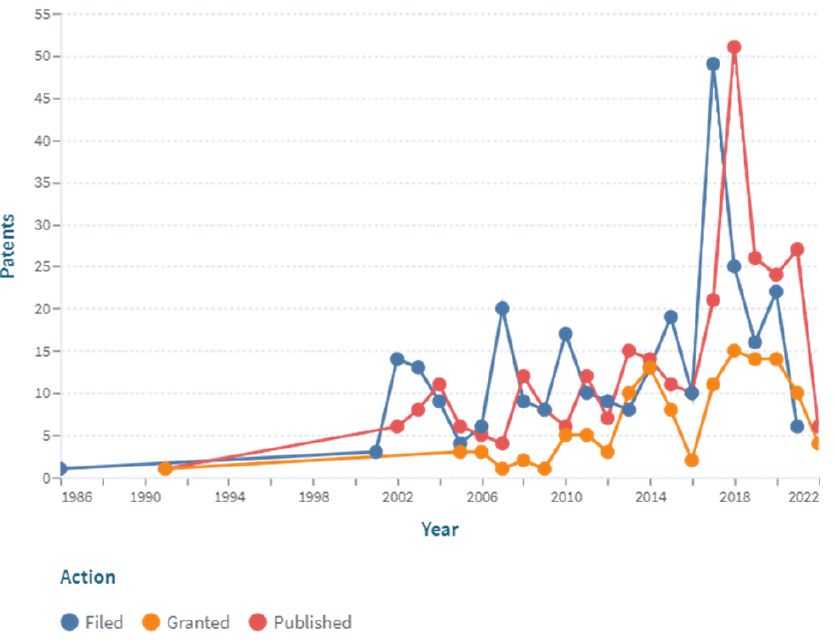
Figure 1. Dynamics of patent activity by applicants in the field of digital pills with ingestible sensor (https://www.lens.org, accessed on 30 July 2022).